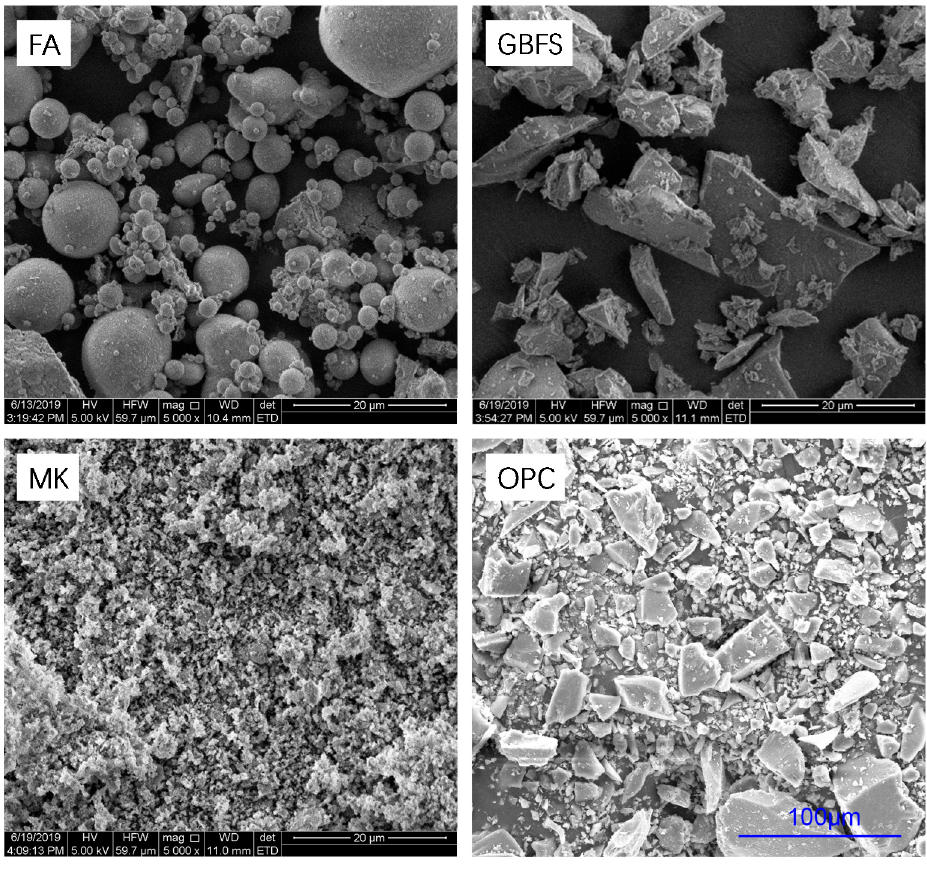
Figure 1. Scanning electron micrographs (SEM) of the precursors used.